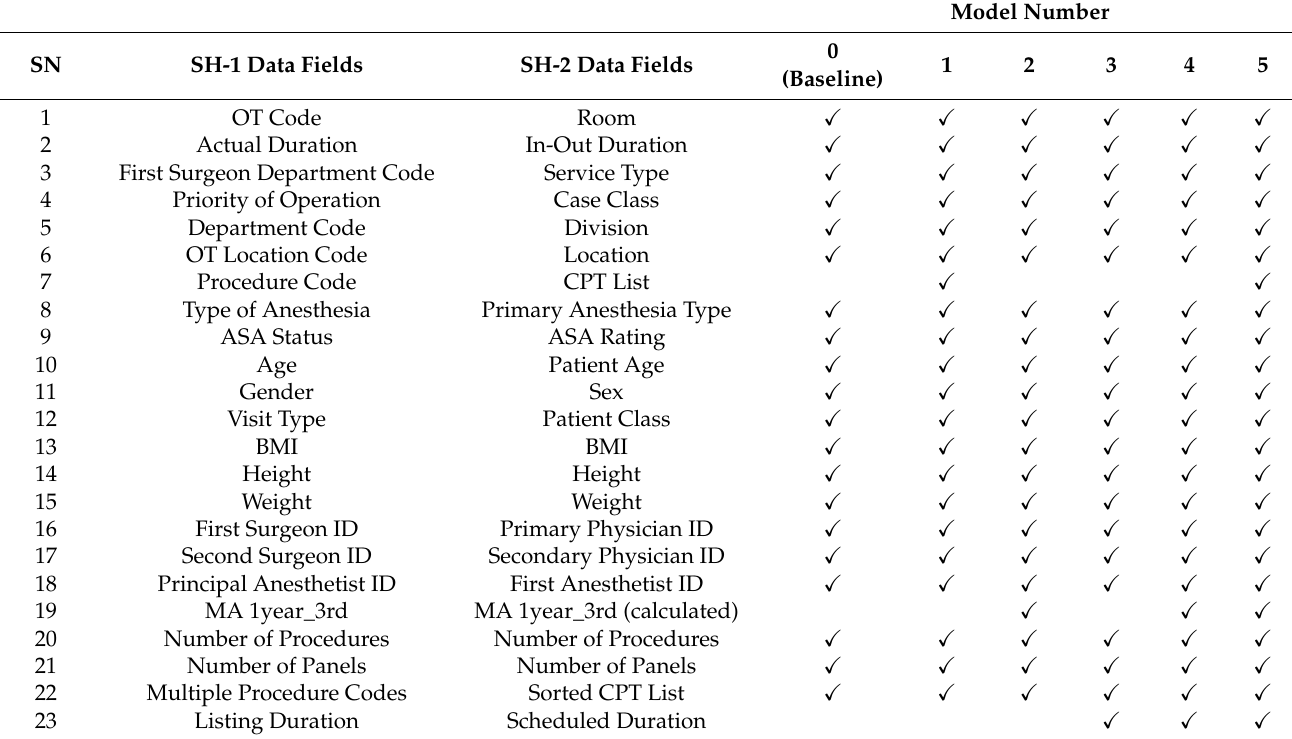
Table A2. List of features present in each CatBoost